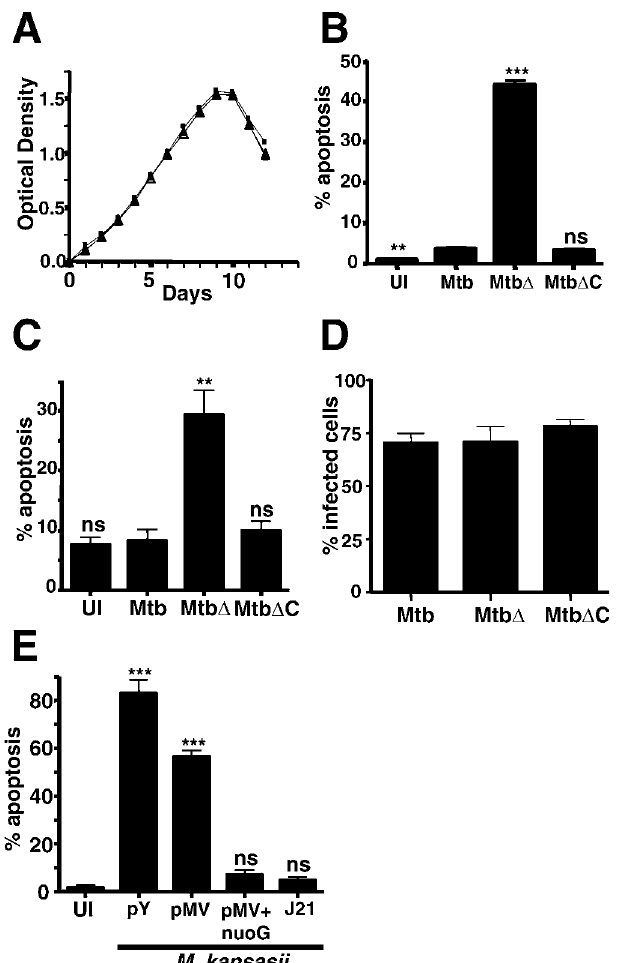
Figure 3. Importance of Mtb nuoG for Inhibition of Macrophage Apoptosis (A) The in vitro growth of wild-type (squares), mutant (full triangles), and complemented bacteria (empty triangles) was analyzed at the indicated time points in triplicate cultures (error bars showing 6 SD are smaller than symbols). (B and C) Induction of apoptosis by infection of differentiated human THP-1 cells (B) or cultured primary mouse macrophages (C) with wild- type (Mtb), the D nuoG deletion mutant (Mtb D ), or complemented mutant (Mtb D C). Cells were harvested either at day 3 (B) or day 1 (C) after infection, stained by TUNEL assay, and analyzed using flow cytometry. (D) The percentage of infected macrophages in (C) was determined by acid-fast staining. (E) M. kansasii was transfected with empty cosmid (pY), empty plasmid (pMV), cosmid J21 (J21), and Mtb nuoG behind the constitutive promoter of pMV261 (pMV þ nuoG), and induction of apoptosis in THP-1 cells was determined by TUNEL staining and flow cytometry. All results shown are means 6 SD of triplicate cultures and are representative of three independent experiments. Asterisks indicate statistical significance as in Figure 1. ns, not significant.